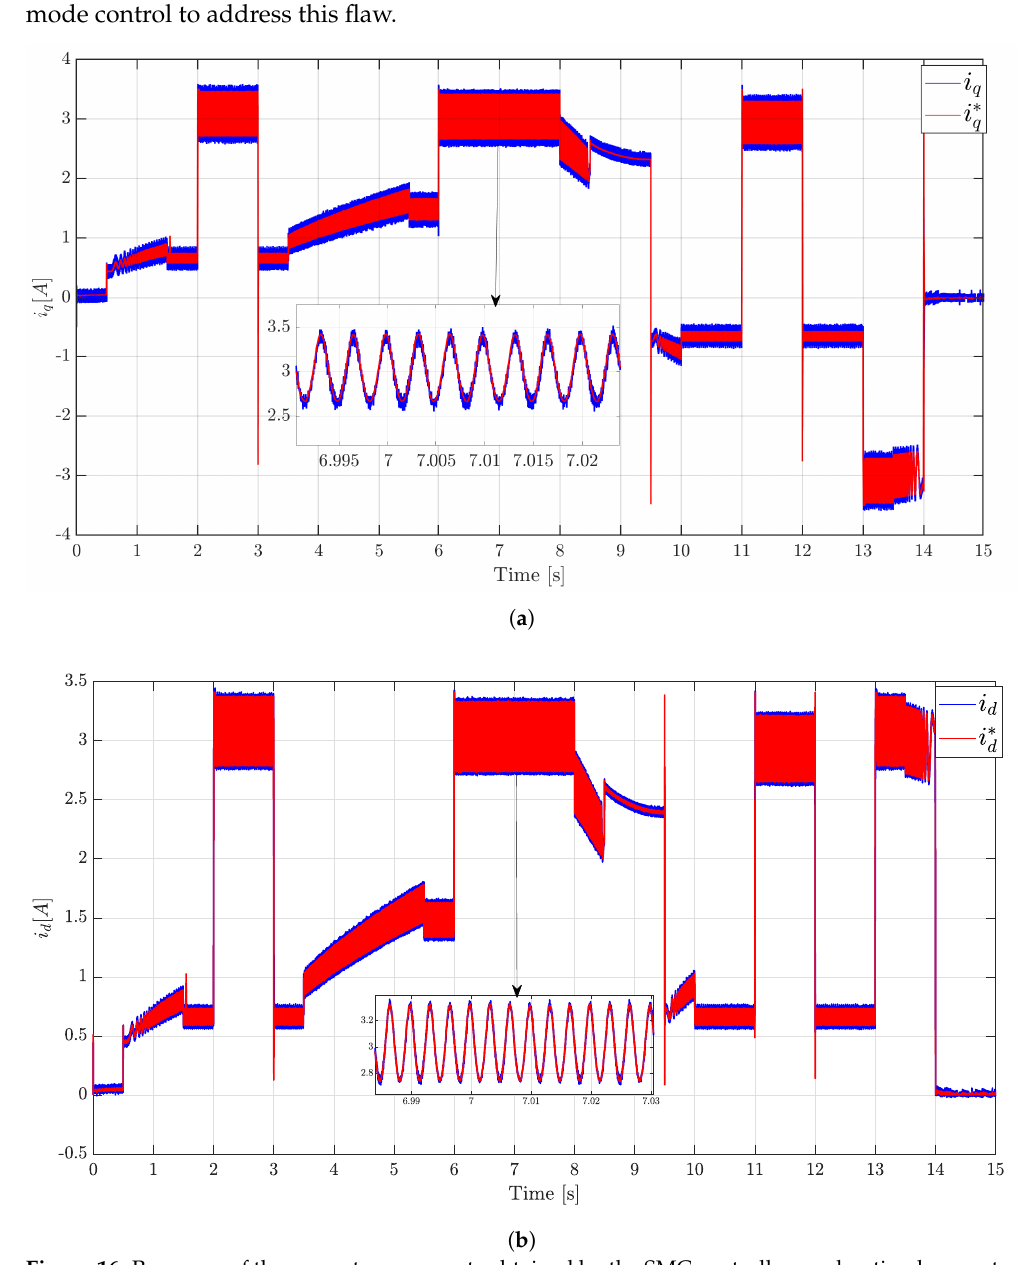
Figure 16. Response of the current components obtained by the SMC controllers and optimal currents calculations method: ( a ) i q response and ( b ) i d